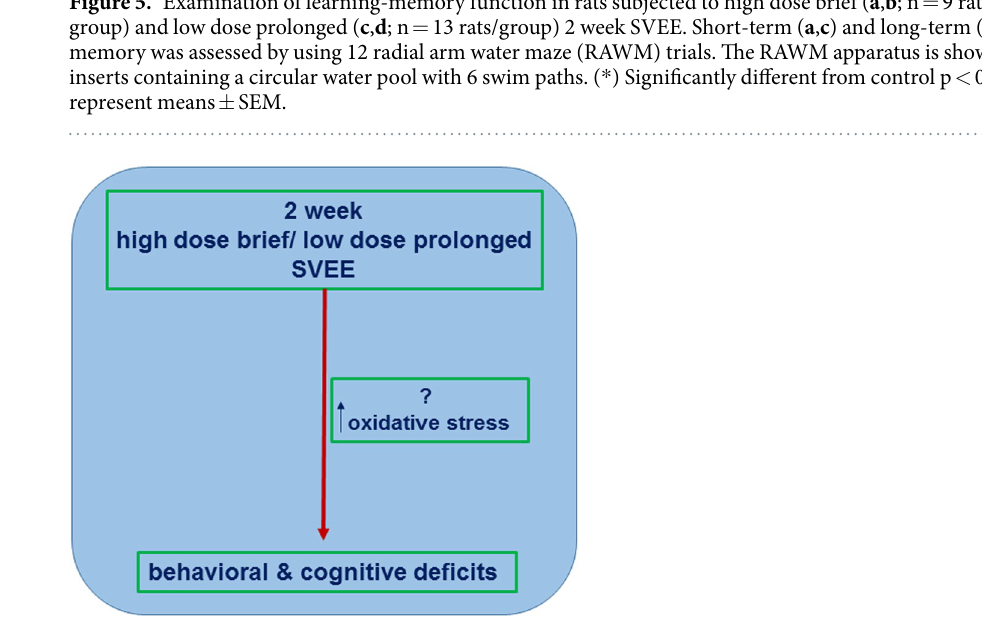
Figure 6. Schematic representation of the events potentially responsible for SVEE-induced behavioral and cognitive